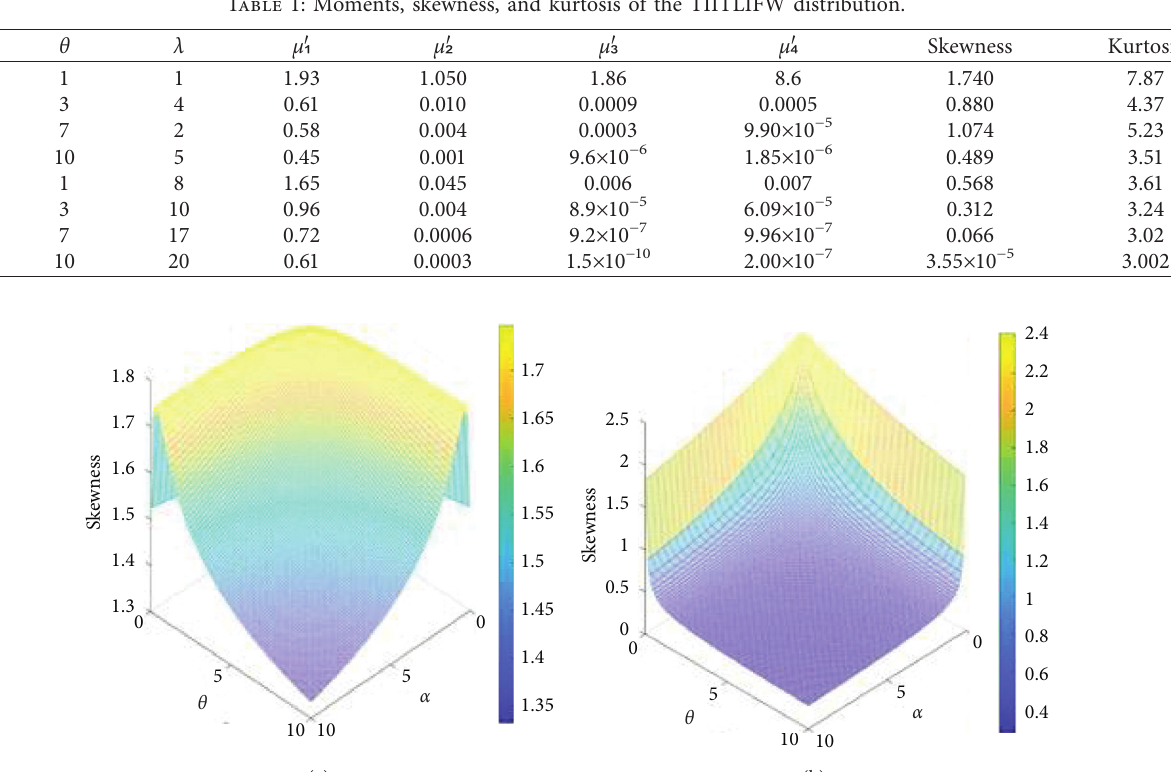
Figure 3: Plots of the skewness of the TIITLIFW distribution. (a) Skewness for λ � 1 . 1. (b) Skewness for λ � 7.